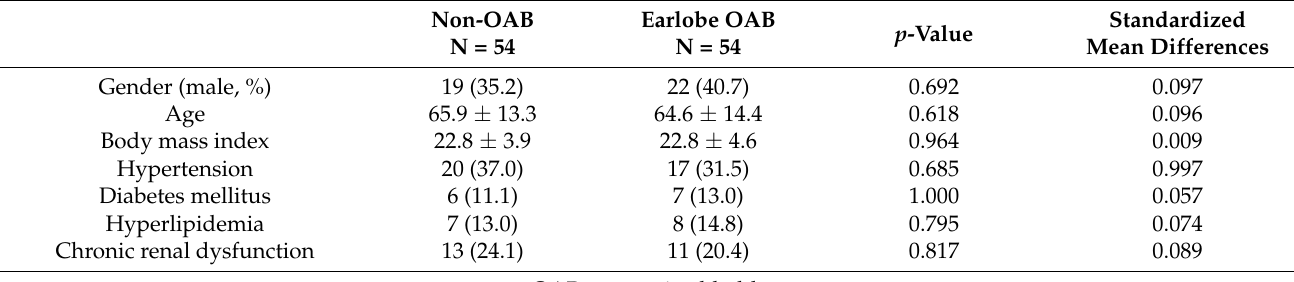
Table 7. Baseline characteristic data of OAB after propensity score